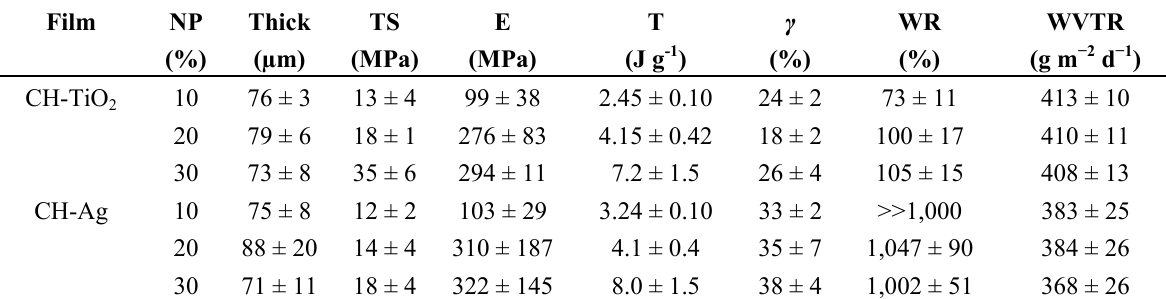
Table 3. Properties of composite films prepared using chitosan, TiO Nano-particle content by weight relative to chitosan (NP), tensile strength (TS), Young’s modulus (E), toughness (T), strain-at-break ( γ ), water resistance (WR), thickness (thick) and water vapor transmission rate (WVTR) for the different composite materials. All samples were prepared with 30% glycerin content by weight relative to chitosan.